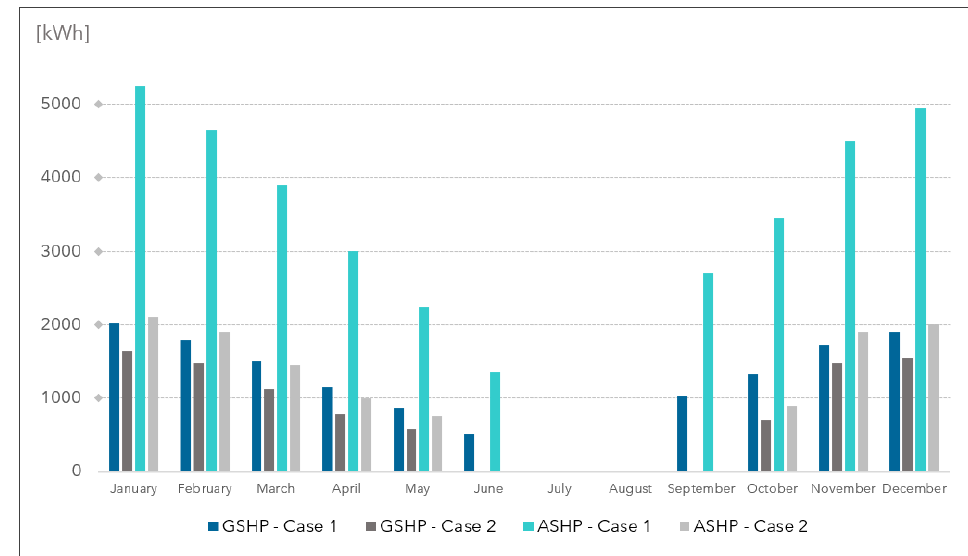
Figure 7. Monthly consumption of the different heat pumps alternatives in each case.